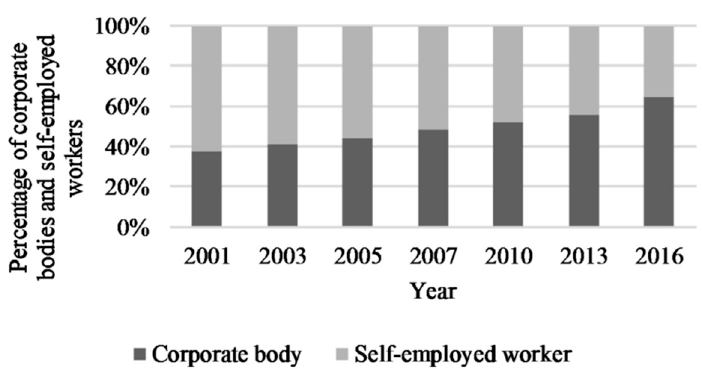
Figure 7. Percentage of corporate bodies and self-employed workers in Estonian agriculture between 2001 and 2016 according to the agricultural area (ha) used by agricultural producers (Statistics Estonia).